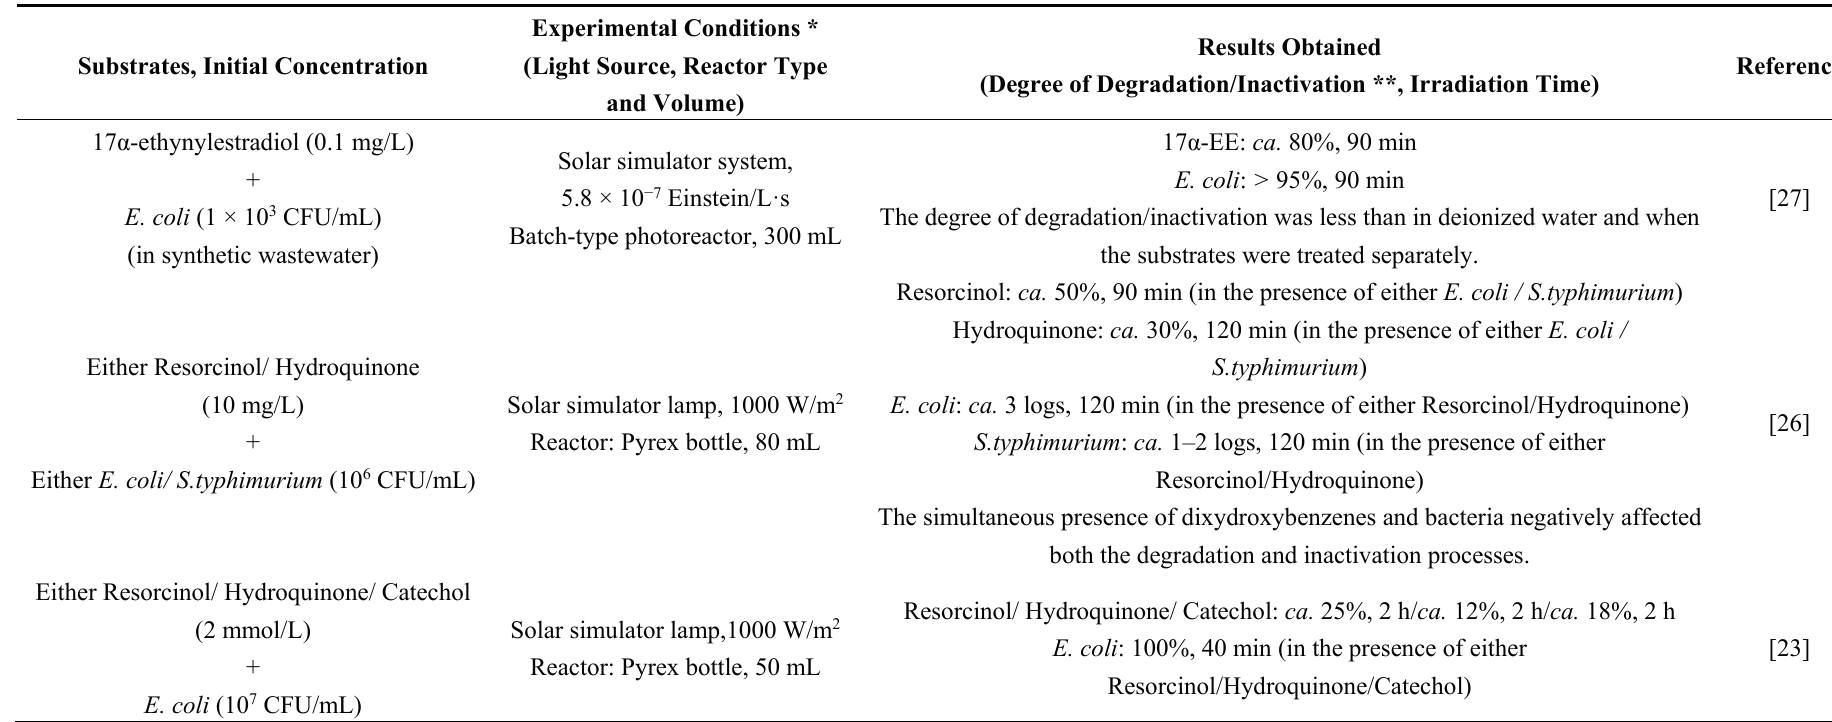
Table 1. Overview of the studies that employed solar-enhanced TiO 2 photocatalysis for simultaneous removal of organic compounds and